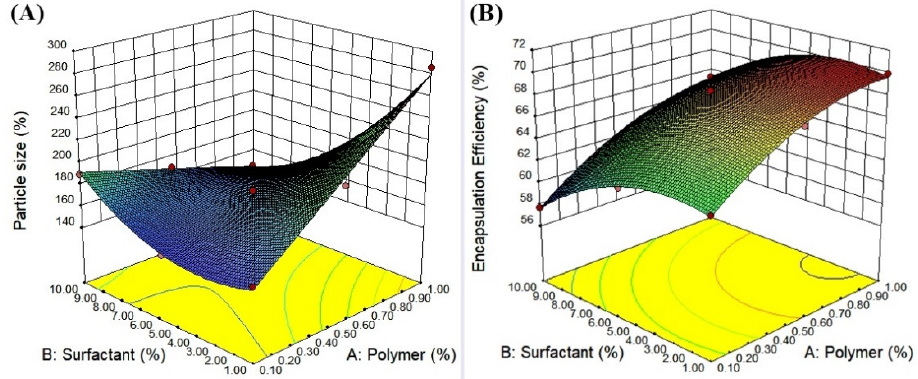
Figure 8. ( A ) Response surface graph showing the effects of pectin and di-octyl sodium sulfosuccinate (DOSS) concentration on the particle size and ( B ) the effectiveness of drug encapsulation in nanoparticles.